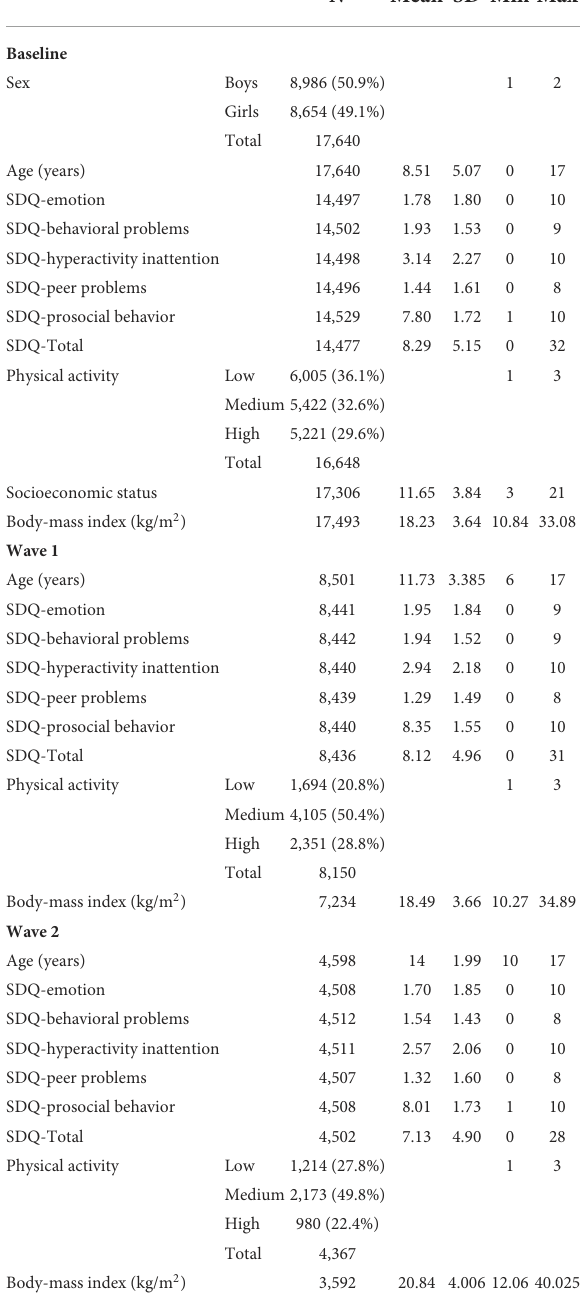
TABLE 1 Descriptive characteristics of the study population at Baseline, Wave 1, and Wave 2.